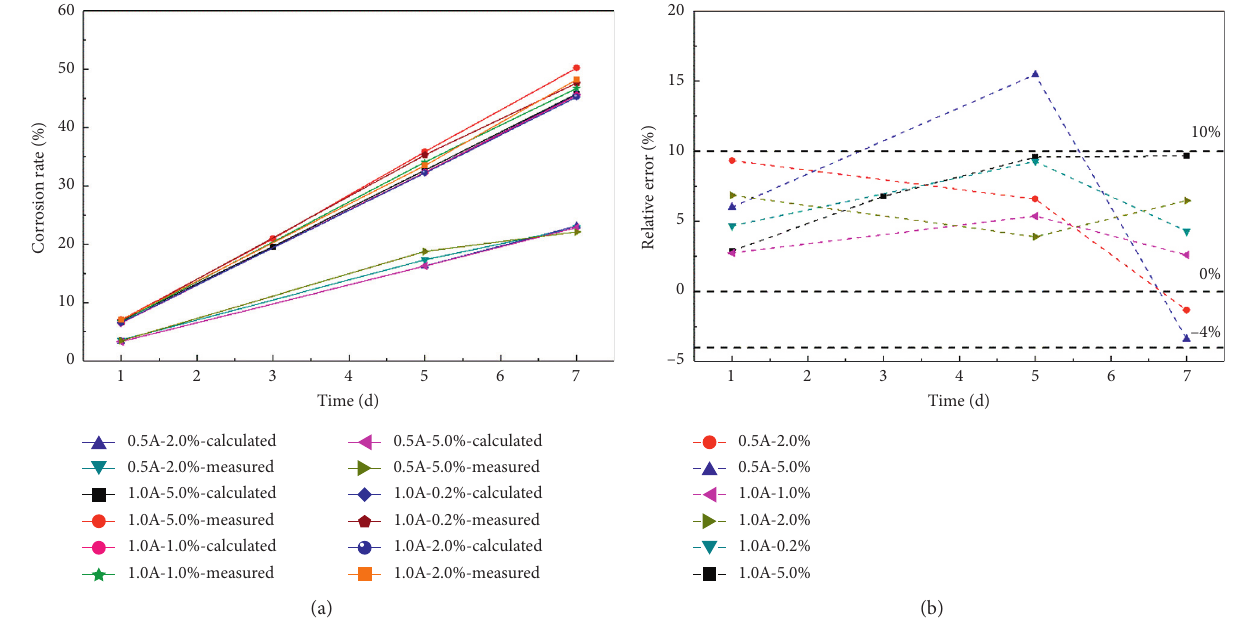
Figure 9: Corrosion rate and RE of anchor samples for different test time.